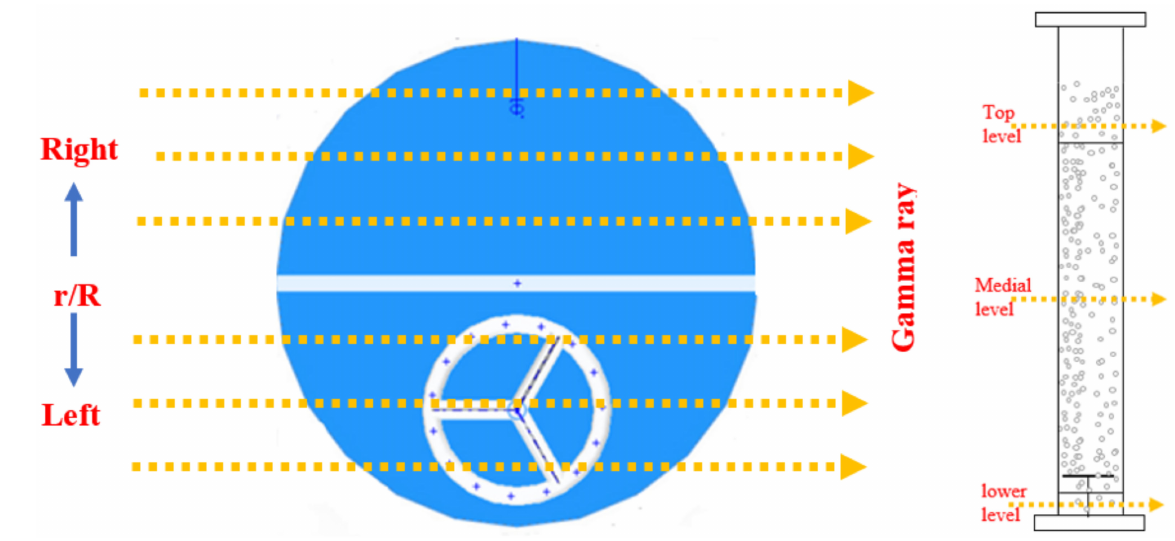
Figure 4. Radial and vertical scanning positions. The vertical measurement distance was at three different positions, lower level (under the split plate) 3 cm from the column base, middle level in 60 cm above the base, and top level at 110 cm from the column